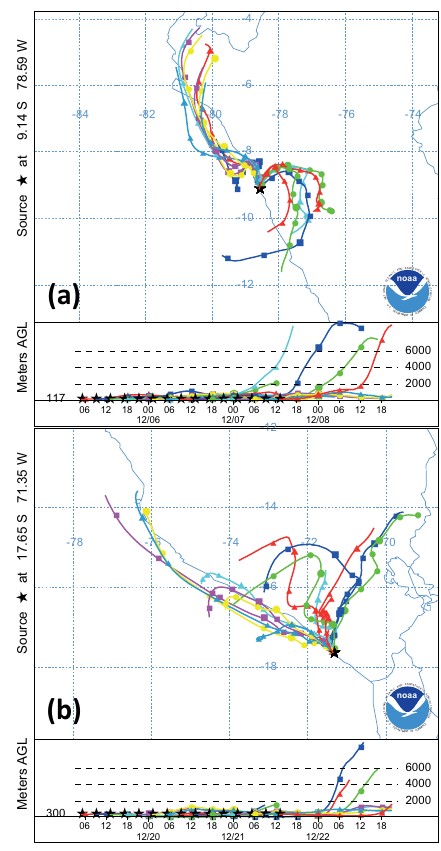
Figure 6. Forward air mass trajectories for the locations of the (a) Chimbote and (b) Ilo metal smelting facilities. Trajectories were run for periods of 48h every 4h over the collection periods of sam- ples (a) TM02 and (b)